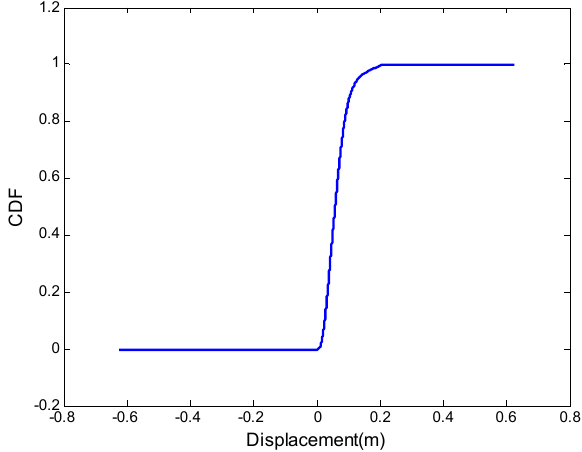
Figure 12. CDF of displacement of laterally loaded pile subjected to stochastic seismic ground motion.